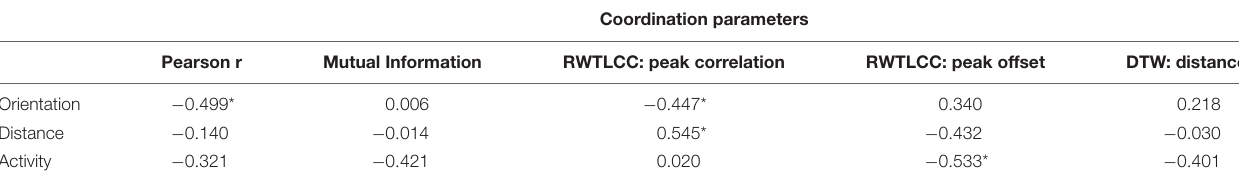
TABLE 4 | Correlations between rapport ratings and coordination parameters for the individual behavior vectors.